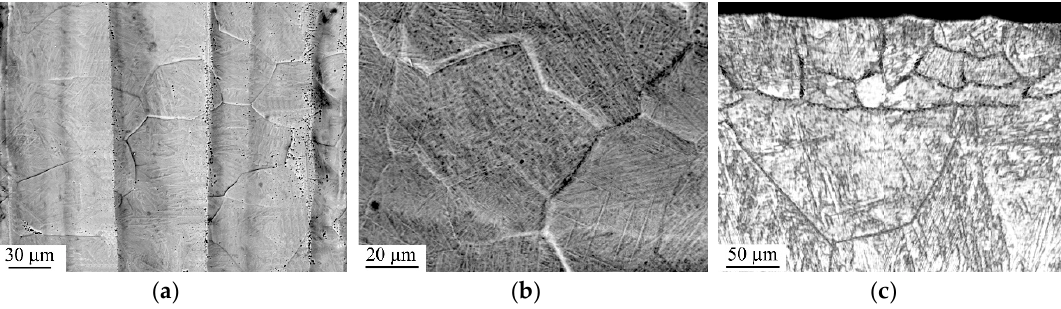
Figure 12. Plan-view ( a,b ) and cross-section ( c ) SEM-images of EBF 3 -fabricated Ti–6Al–4V samples subjected to electron beam treatment.